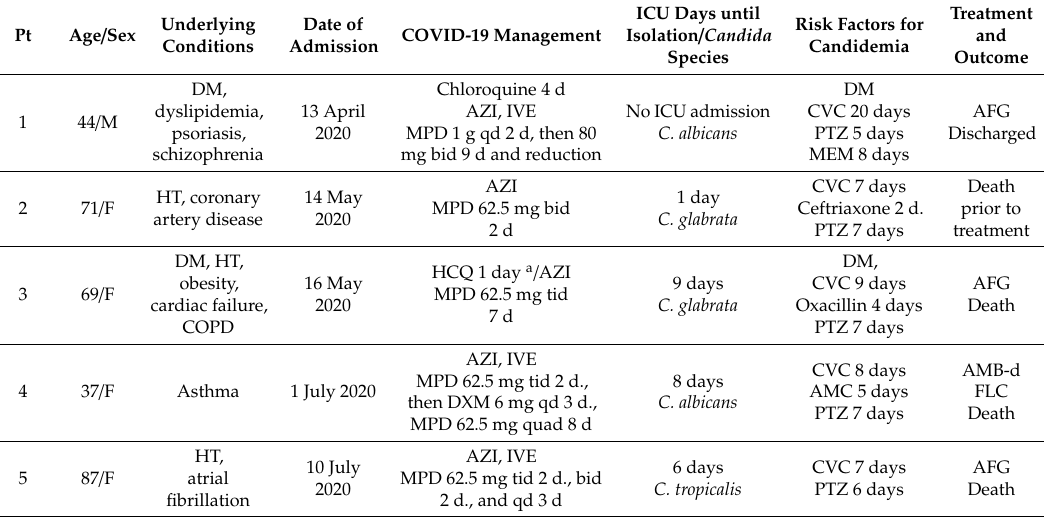
Characteristics of patients who had candidemia following corticosteroid use for severe